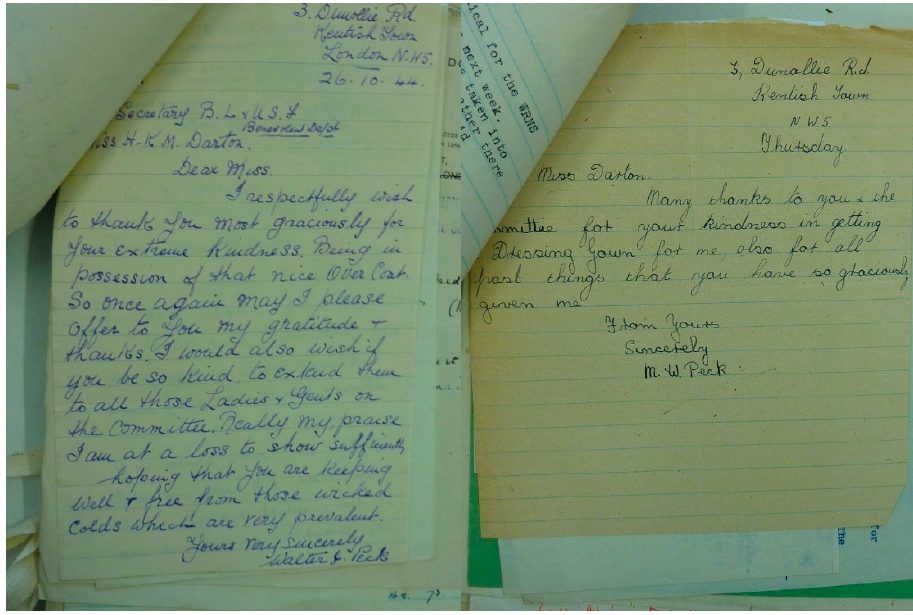
Figure 3. Thank you letters to COS from Mr. Peck, 26 October 1944, and Muriel Peck, undated.